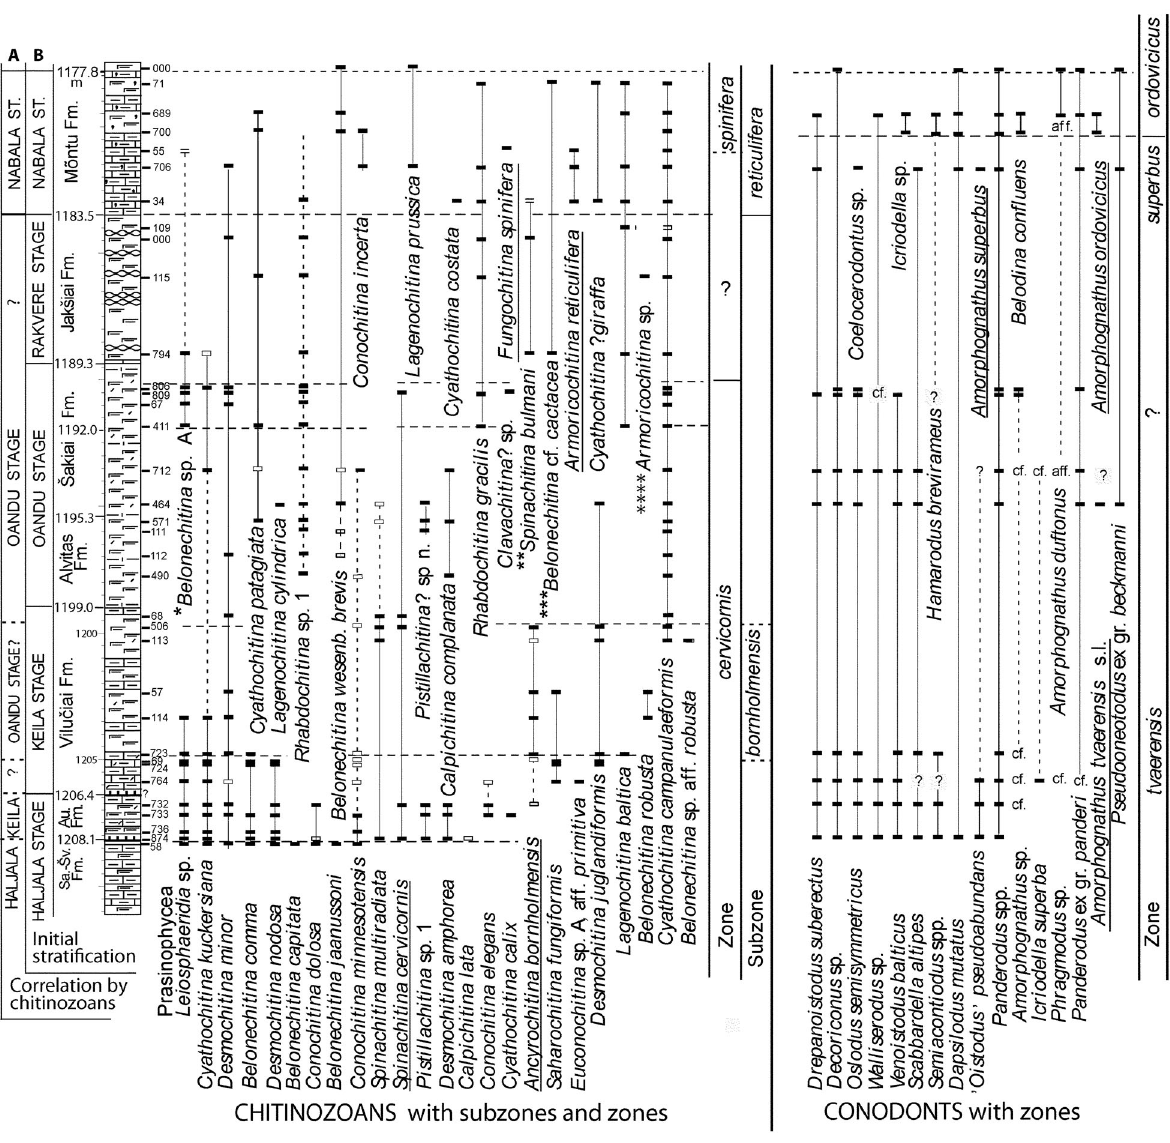
Fig. 4. Distribution of chitinozoans and conodonts, biozones and subzones in the Pajevonys-13 core. On the left side of the log: A, correlation of formations in terms of chitinozoans; B, as in Fig. 3. Chitinozoan species identified sensu Vandenbroucke et al. (2013) * Belonechitina sp. A as specimen in pl. 3, fig. i; ** Spinachitina bulmani as in pl. 2, figs h–m; *** Belonechitina cf. cactacea as in pl. 4, figs a, d; **** Armoricochitina sp. as in pl. 5, fig. h. For the lithological legend refer to Fig.